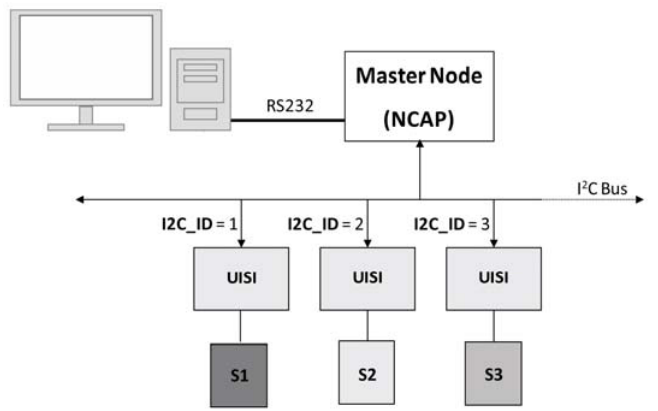
Figure 13. Experimental setup scheme.